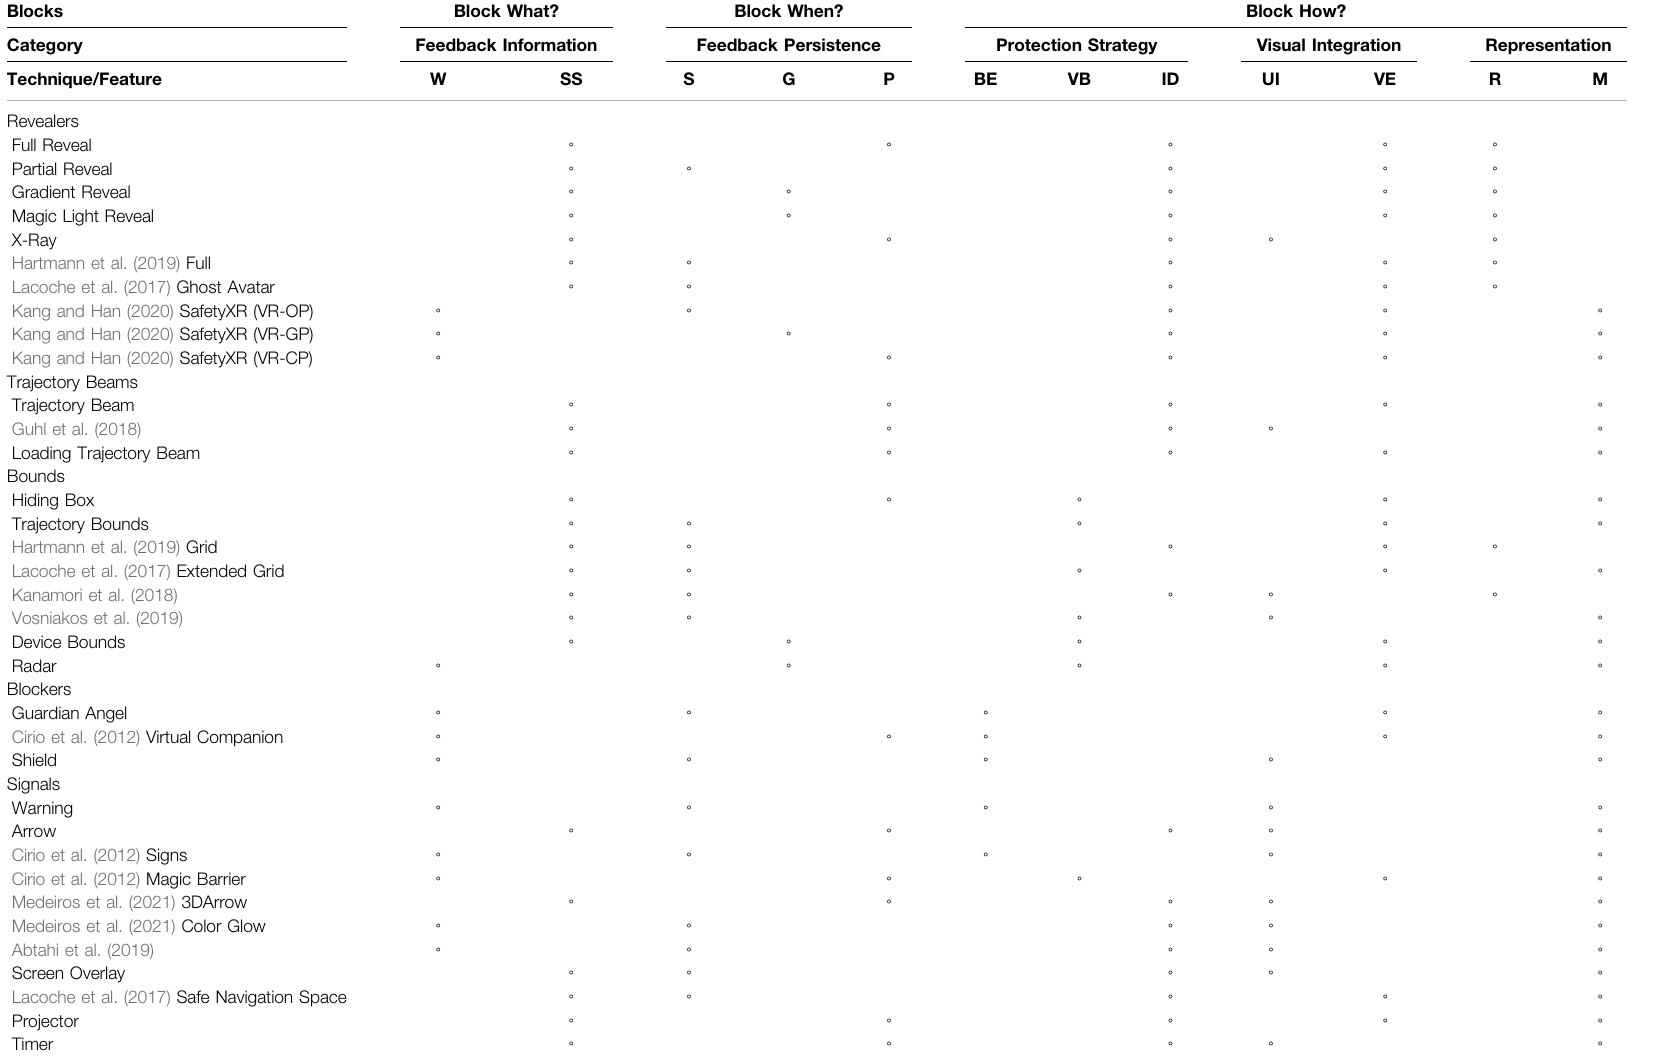
◦ ◦ ◦ ◦ Abtahi et al. (2019) ◦ ◦ ◦ ◦ ◦ Screen Overlay ◦ ◦ ◦ ◦ ◦ Lacoche et al. (2017) Safe Navigation Space ◦ ◦ ◦ ◦ ◦ Projector ◦ ◦ ◦ ◦ ◦ Timer ◦ ◦ ◦ ◦ ◦ Thefeatures ’ namesareabbreviated:W,warning;SS,system ’